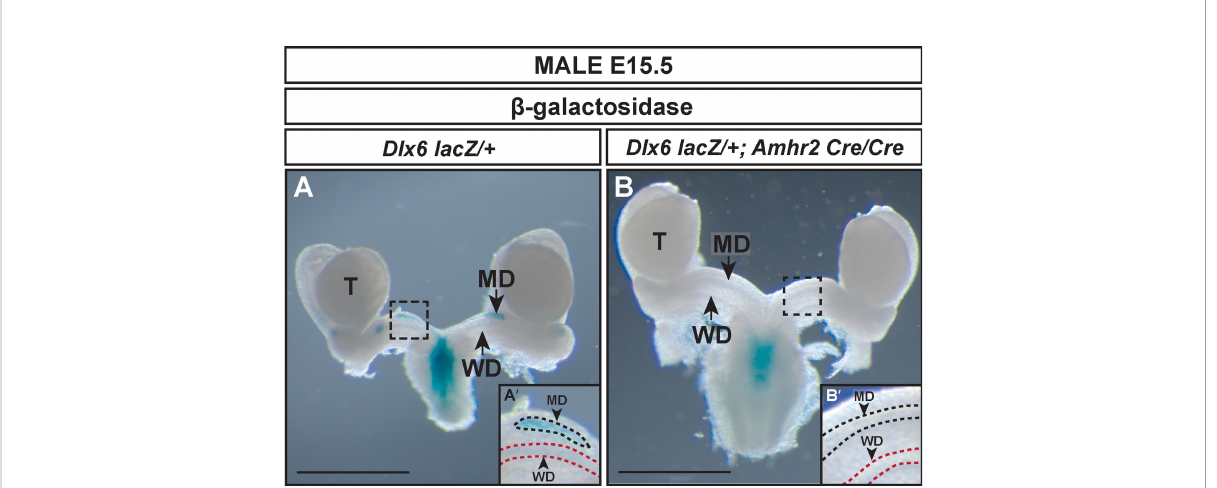
FIGURE 4 AMH signaling is required for Dlx6-lacZ expression in the Müllerian duct. Wholemount b -gal-stained urogenital organs from E15.5 Dlx6-lacZ /+ (A) and Dlx6-lacZ /+; Amhr2-Cre/Cre (B) male embryos. Arrow in (A) , residual b -gal-stained Müllerian duct (MD) tissue. Arrow in (B) , absence of b -gal-stained Müllerian duct tissue in fully retained Müllerian duct caused by loss of Amhr2 . Dashed square boxes show location of higher magni fi cation insets. MD, Müllerian duct; T, testis; WD, Wolf fi an duct. Scale bars=1000 µm. ( A ’ , B ’ ) Higher magni fi cation insets. Arrowheads, Müllerian ducts, MD; Wolf fi an ducts, WD. Dotted lines surround MD (black) and WD (red). Each genotype analyzed